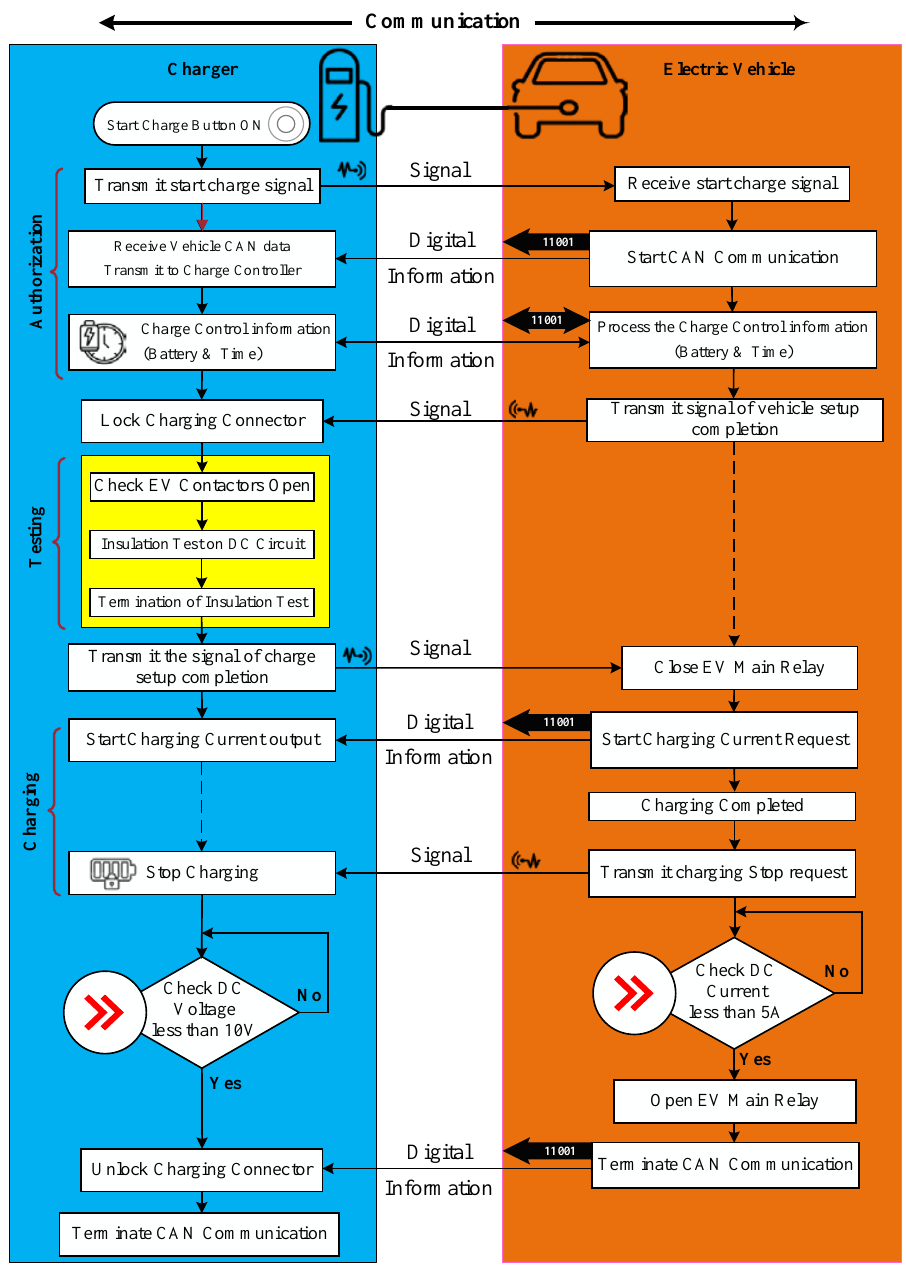
Figure 5. Charging sequence and control communications.